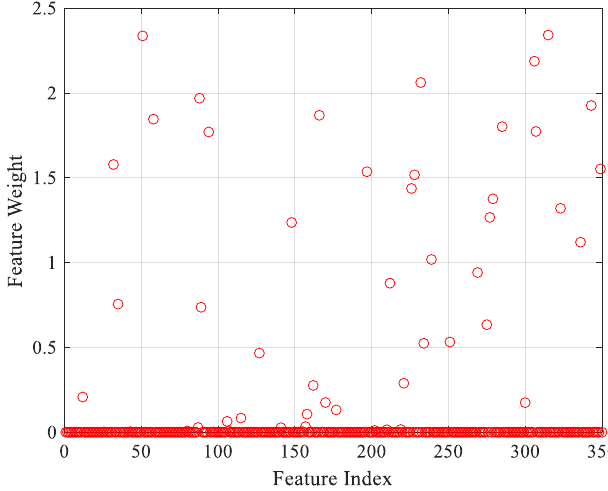
Figure 6. Deep feature weights for each feature index.